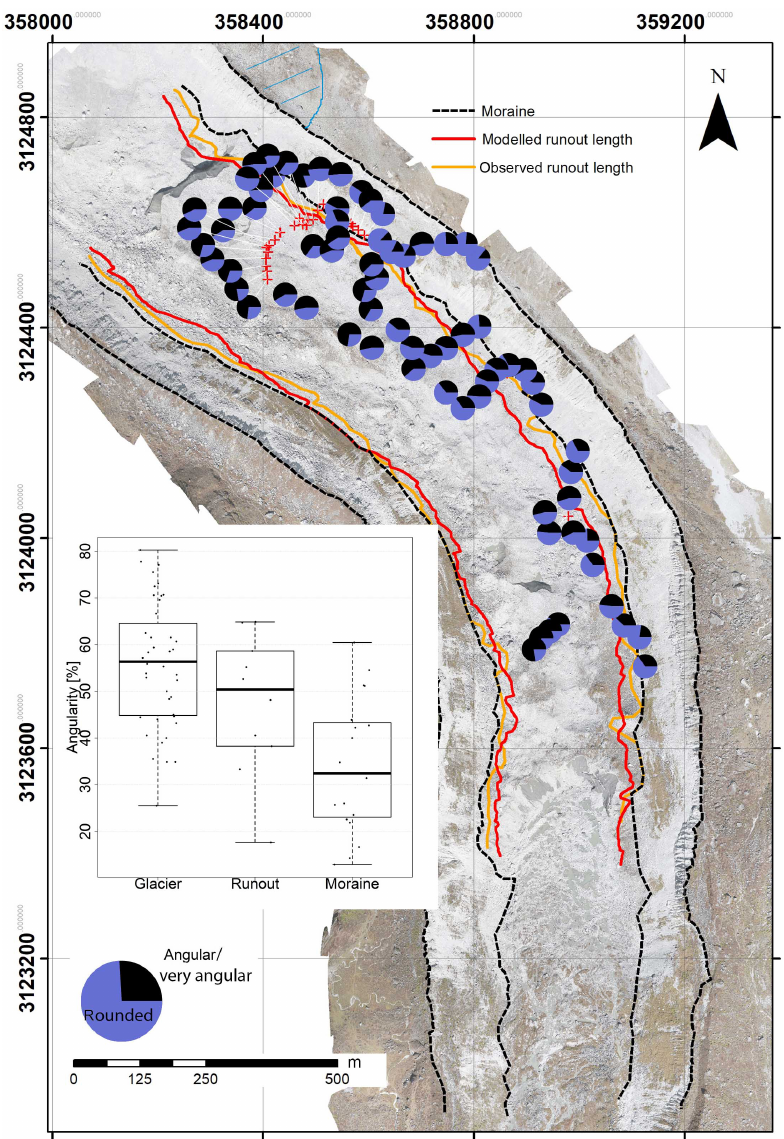
Figure 10. Angularity samples taken on the glacier surface; observed and modelled runout lengths are also shown. The inset shows angularity values for samples beyond the modelled runout length (“glacier”), between the runout length and the base of the moraine (“runout”) and on the moraine (“moraine”). In the top right corner, marked in blue, the glacier is still connected to rockwalls by way of